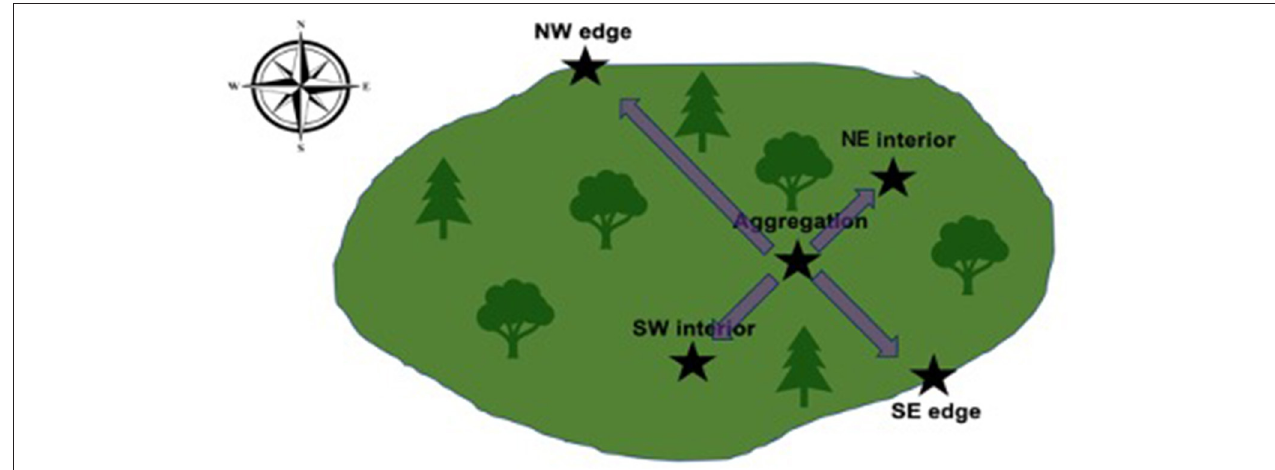
FIGURE 3 | Sampling design relative to the aggregation’s location in the groves. The first sample location was placed in the location of an aggregation (Aggregation). Two more sample locations were placed on the SE and NW edges of each grove relative to the aggregation’s location to capture morning light and prevailing wind (SE edge and NW edge, respectively). Two interior sample locations were placed halfway between the aggregation’s location and the grove’s edge in the NE and SW directions (NE interior and SW interior,